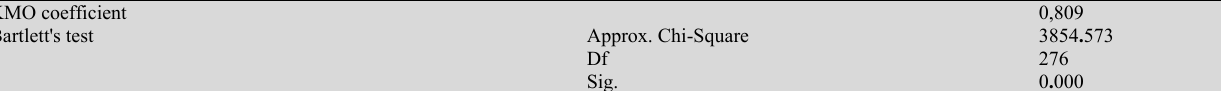
KMO coefficients and Bartlett's tests of independent factors